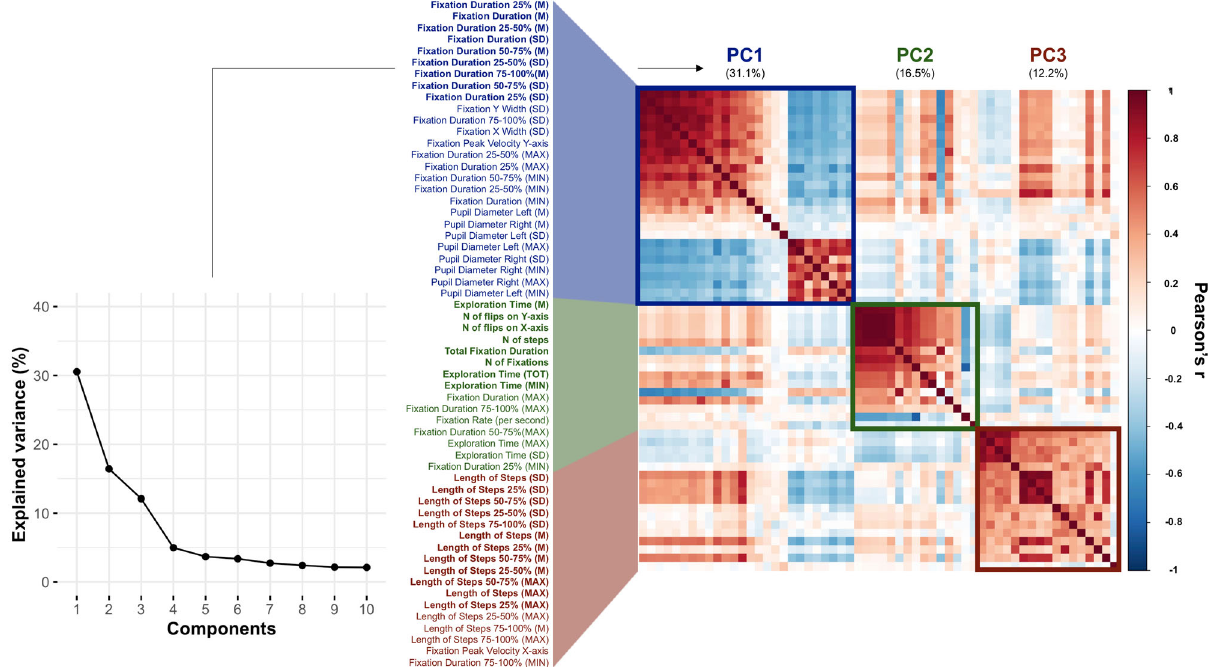
Fig. 2 Correlation matrix of spatiotemporal features and principal components (PCs). The line plot shows the variance explained by different PCs. The matrix shows the correlation (Pearson ’ s r ) between features, which are ordered according to their loadings in the fi rst three PCs. The colour of Y -axis labels indicates the PC with the highest loading for the corresponding feature, and features written in bold are those with loadings > 0.2.